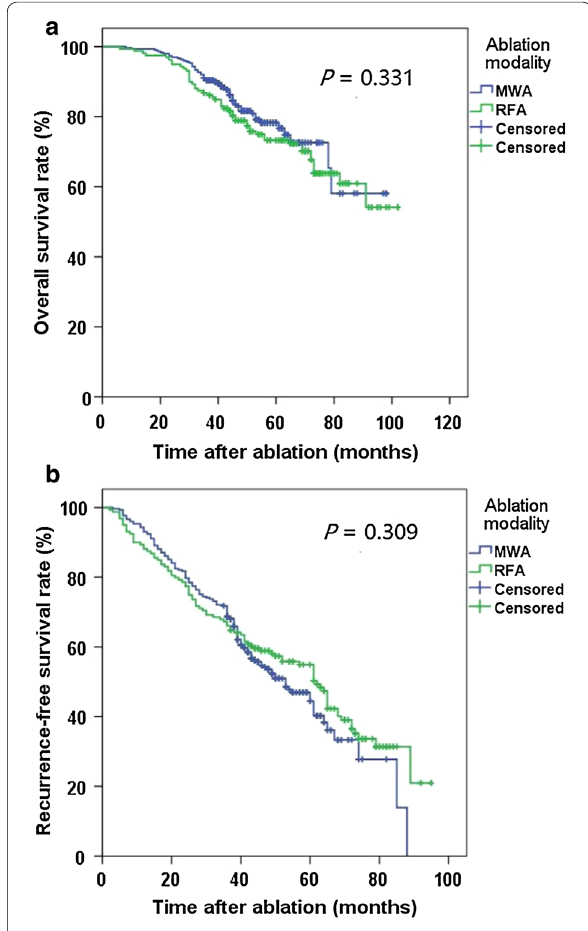
Fig. 2 Survival curves for HCC patients treated with radiofrequency ablation (RFA) and microwave ablation (MWA). Survivals were evalu‑ ated using Kaplan–Meier curves and compared with the log‑rank test. No significant differences are observed between the two groups. a Overall survival curves; b recurrence‑free survival